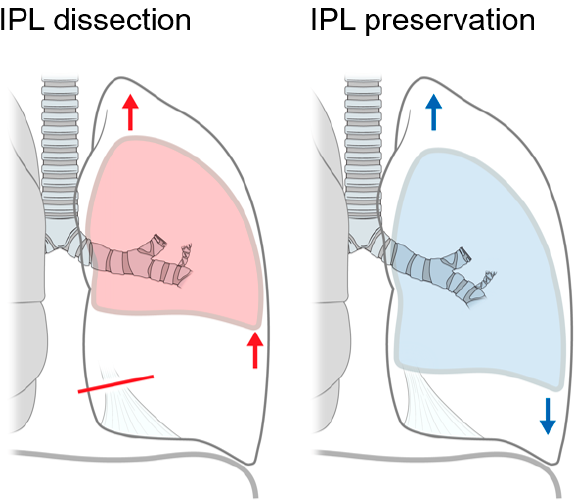
Figure 5. Effects of inferior pulmonary ligament preservation during left upper lobectomy. Red line: dissection of inferior pulmonary ligament (IPL); Red arrows: possible lung expansion with IPL dissection; Blue arrows: possible lung expansion with IPL preservation. Inferior pulmonary ligament preservation during left upper lobectomy may be ben ‐ eficial for left lower lobe expansion with less movement and positional change of the left main bronchus.